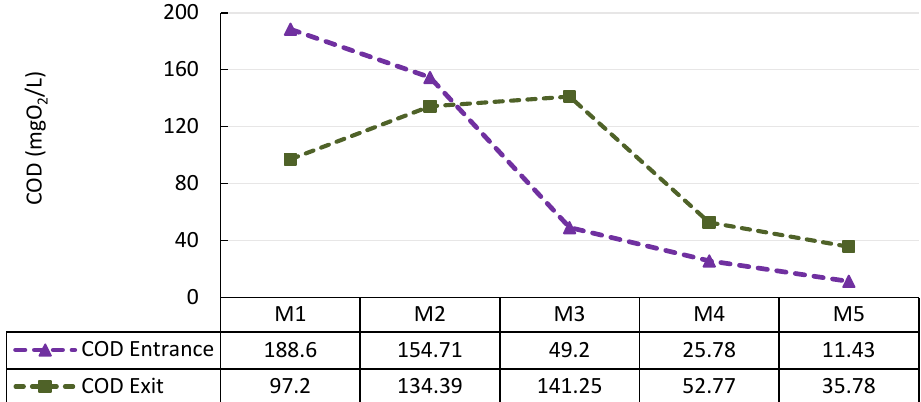
Fig. 5: Biological oxygen demand of the treated and untreated effluents in the 5 sampling